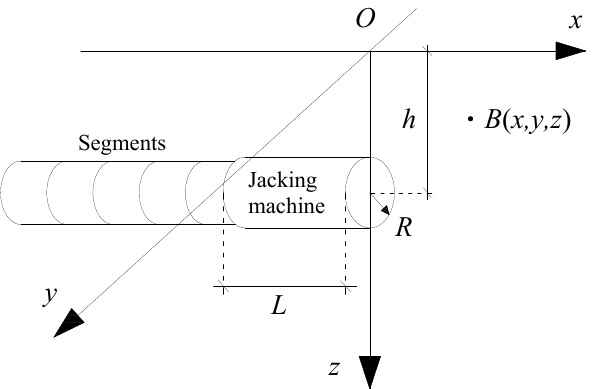
Figure 2. Calculation schematic of Mindlin’s solution.